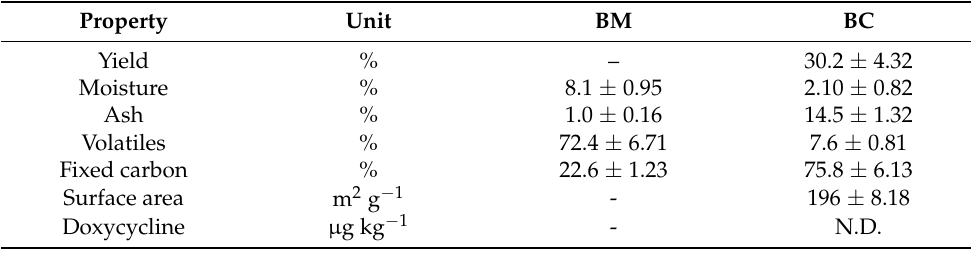
Table 2. Proximate analyses, surface area, and elemental composition of the mesquite wood waste biomass (BM) and its derived biochar (BC) used in this